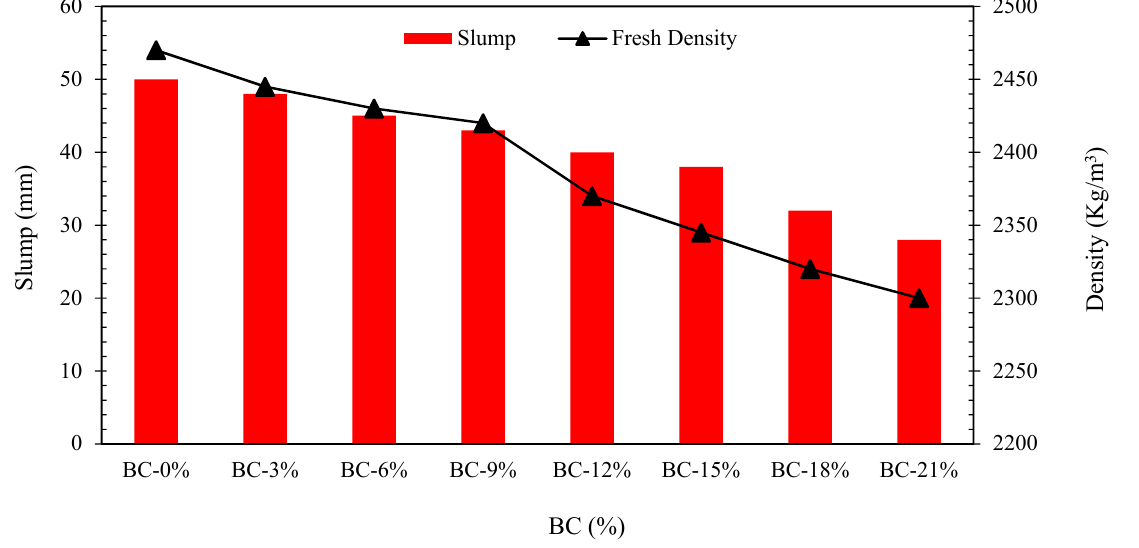
Figure 3. Workability and fresh density (data source [44]).